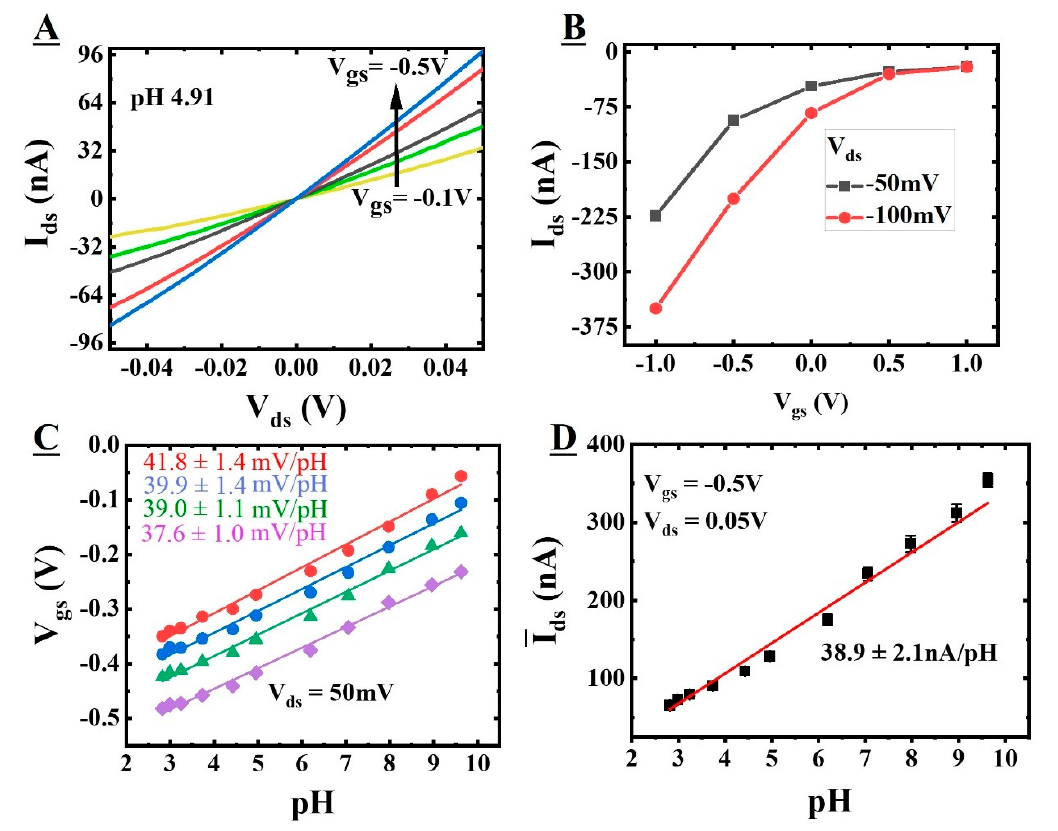
Figure 4. I-V characteristics at fixed pH of 4.91 ( A ) I ds vs. V ds for a varying gate voltage, applied via the reference electrode ( − 0.1 to − 0.5 V in steps of − 0.1 V) with V ds ranging from − 0.05 V to 0.05 V, and ( B ) I ds vs. V gs for input gate voltage range of − 1 to 1 V, applied via the reference electrode for a V ds